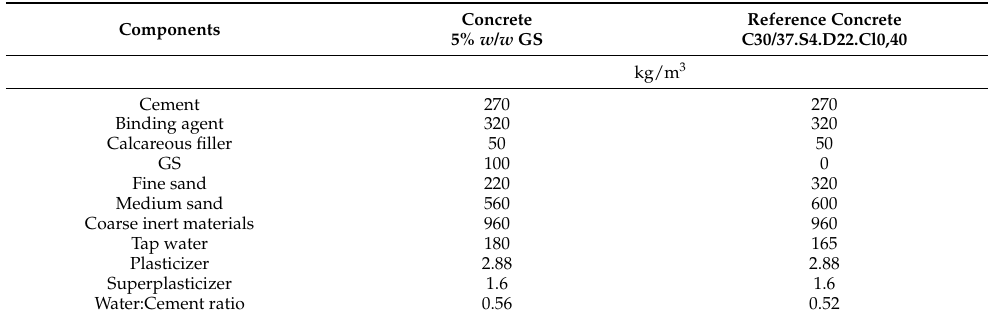
Table 1. Concrete formulations incorporating 5% w / w GS (Concrete 5% w / w GS) and reference concrete